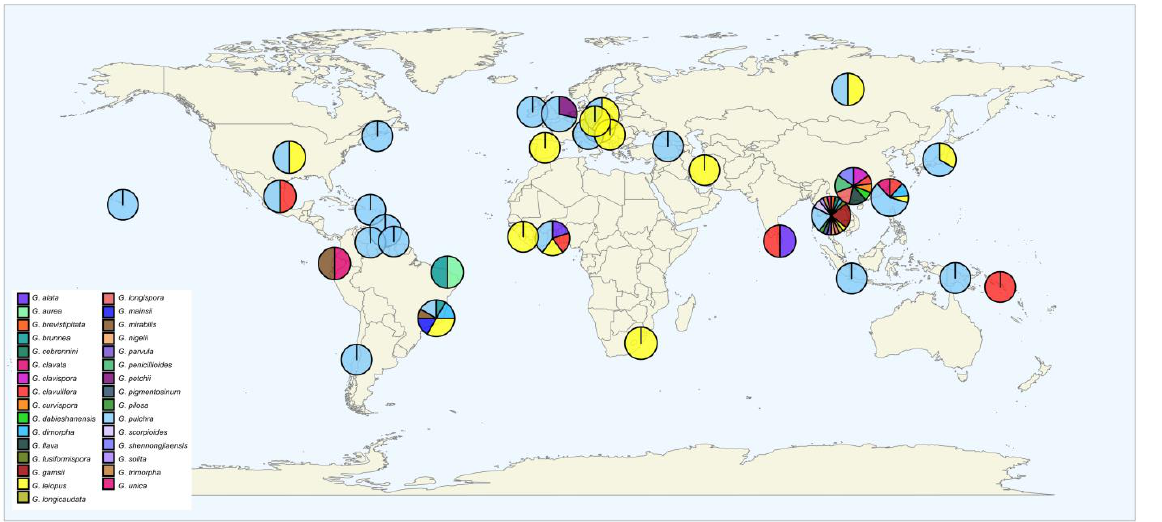
Figure 5. Global distribution of the fungus Gibellula infecting spiders. Species shown at the bottom left are the ones considered as accepted species in this review. Location was extracted from the 57 papers included in our databases.